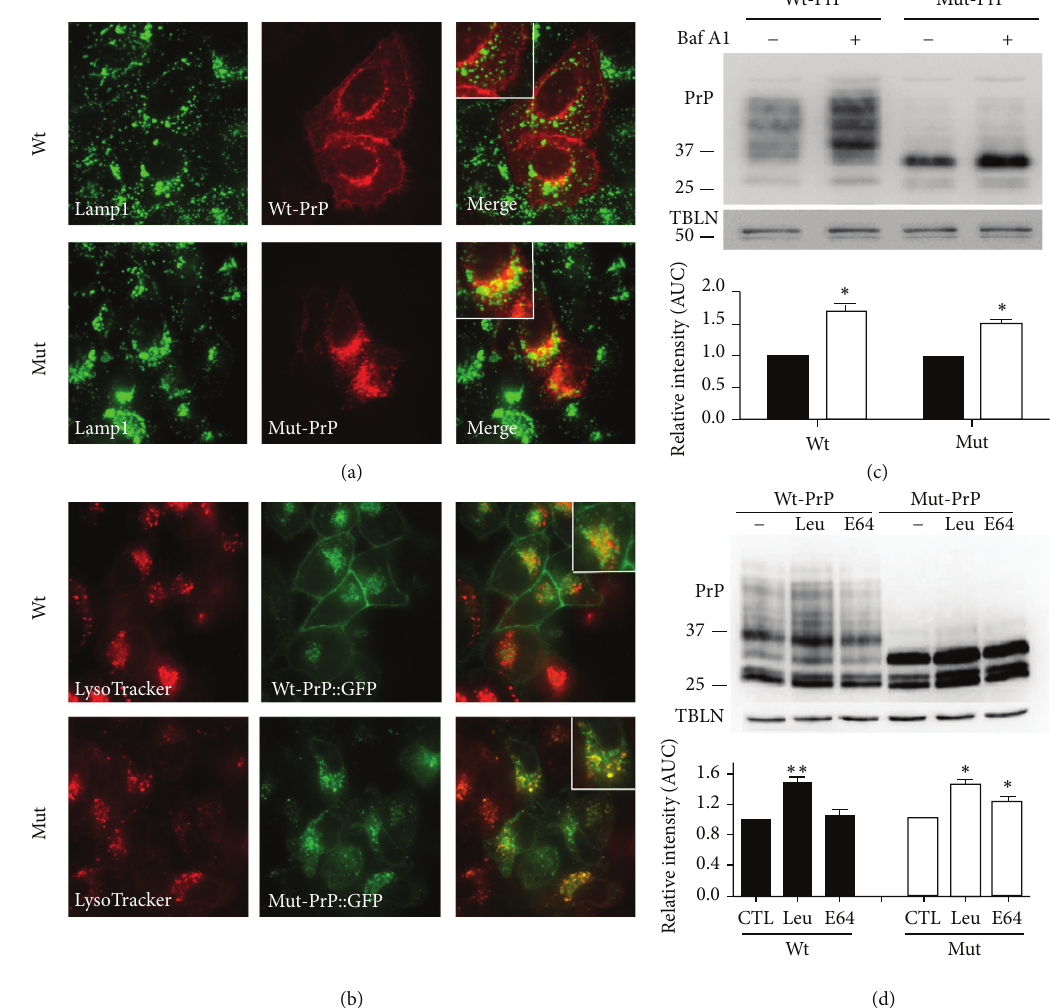
Figure 2: Mut-PrP in lysosomes. (a) Indirect immunofluorescence confocal microscopy of fixed HeLa cells after 16h expression of Wt- or Mut-PrP, detected with anti-mouse-PrP D13 F(ab) antibody. Red (PrP) and green (LAMP-1) channels are displayed separately to the left of merged images. Yellow indicates colocalization. (b) Live cell fluorescence microscopy of HeLa cells transiently expressing Wt-PrP::GFP or Mut-PrP::GFP in the presence of 50 nM LysoTracker Red shows comparable results with indirect immunoflourescence. (c) Western blot of total lysates of COS-7 cells transiently expressing Wt- or Mut-PrP after 16h incubation with vehicle ( − ) or 0.1 𝜇 M Bafilomycin A1 (Baf A1) added to the media. PrP is detected with the D13 antibody. Graphic representation of densitometric signal of Western blot from 3 experiments is displayed below. (d) as in (c), but following incubation in the absence ( − ) or presence of 100 𝜇 M Leupeptin (Leu) or 20 𝜇 M E64, probed with D13. 𝛼 -tubulin (TBLN) as a loading control in (c) and (d). Molecular weight markers (kDa) on the left. Densitometric quantification of blots in (c) and (d) is shown in graphs as relative intensity compared to untreated condition. ∗ 𝑃 < 0.05 , ∗∗ 𝑃 < 0.005 (Student’s paired 𝑡 -test, 𝑛 = 3 experiments